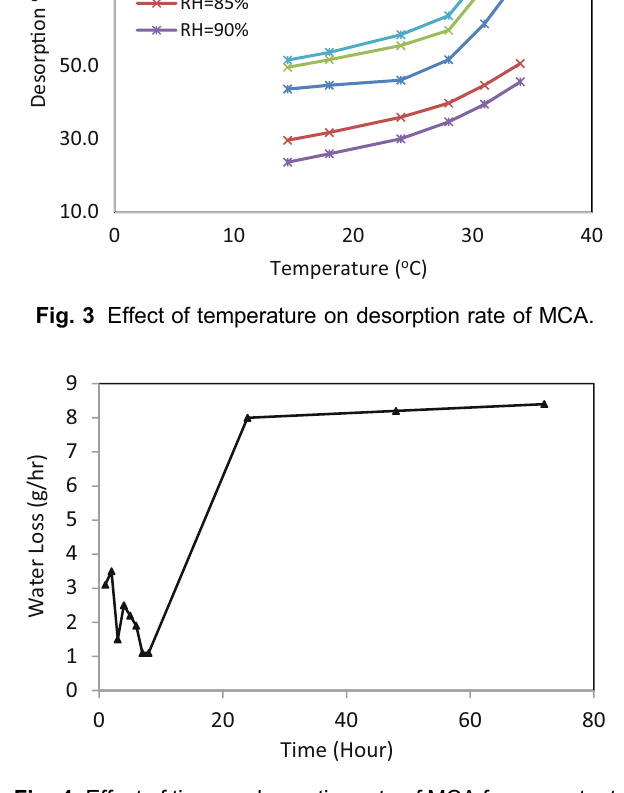
Fig. 4 Effect of time on desorption rate of MCA for a constant temperature (34 (cid:3) C) and constant relative humidity